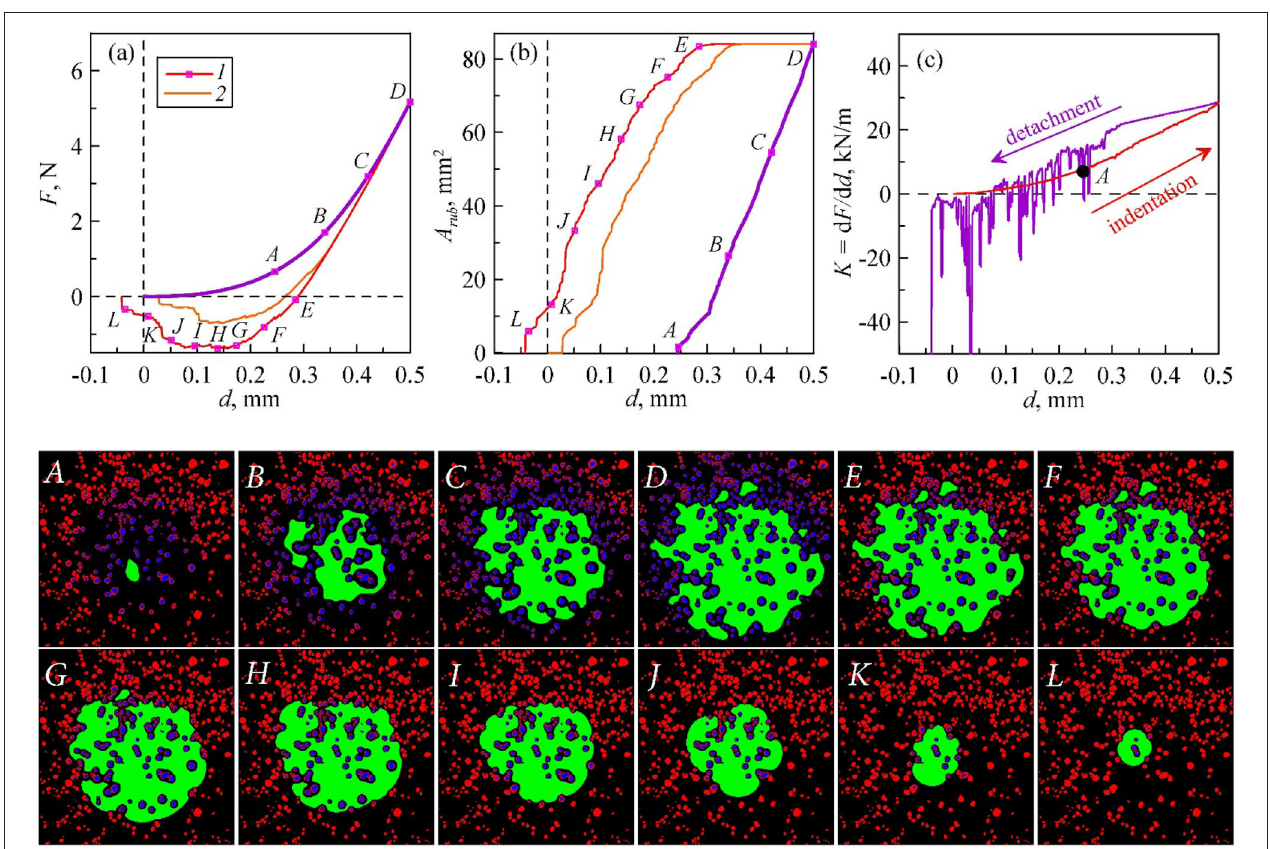
FIGURE 7 | Simulation of adhesive contact of spherical indenter on elastomer layer with particles. Dependencies of normal force (a) , contact area (b) , and contact stiffness (c) on indentation depth. The images below show the contact zones in different colors: black—noncontact area without particles; red—noncontact area with particles; blue—contact area between elastomer and particles (asperities of indenter); green—direct contact region between elastomer and